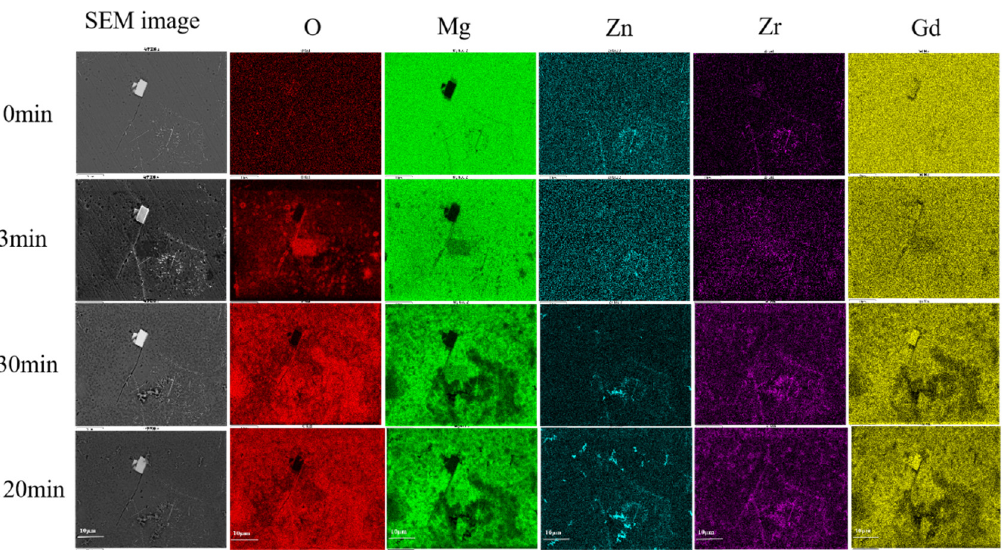
Figure 9. SEM images and element distribution maps of GZ91K alloy following various immersion durations.